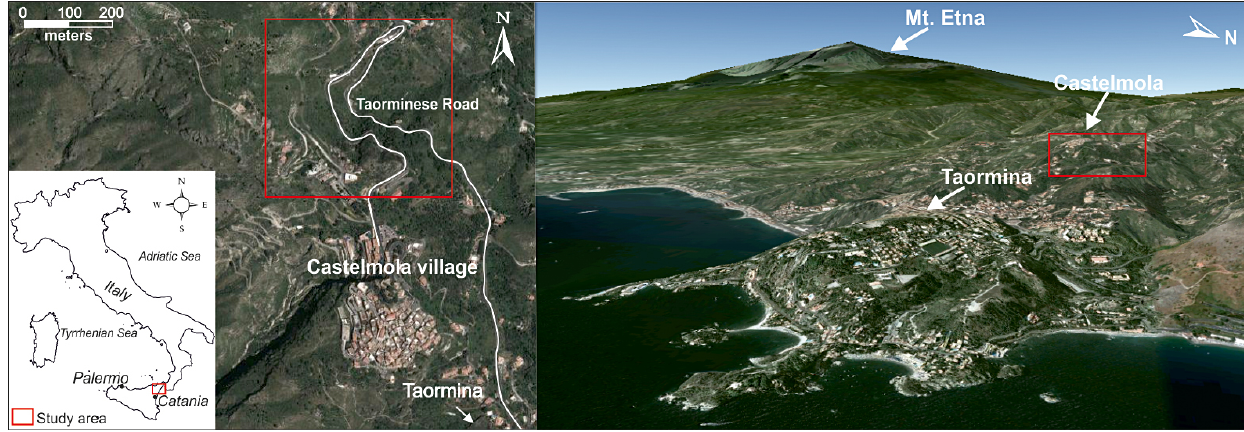
Figure 1. Geographical location of the study